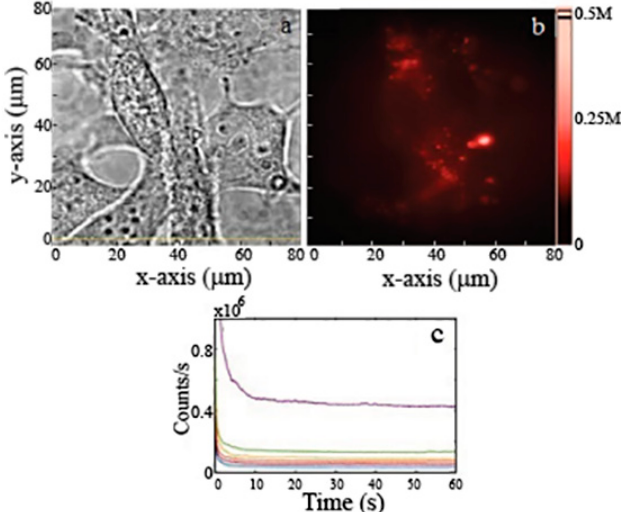
Figure 6. ( a ) Brightfield and ( b ) widefield fluorescence images, fibroblast cells cultured with ball- milled MgO NPs. ( c ) Emission counts recorded as a function of time for NPs cultured in different cells. Excitation power was 300 mW at the back of the objective distributed over a widefield scan area